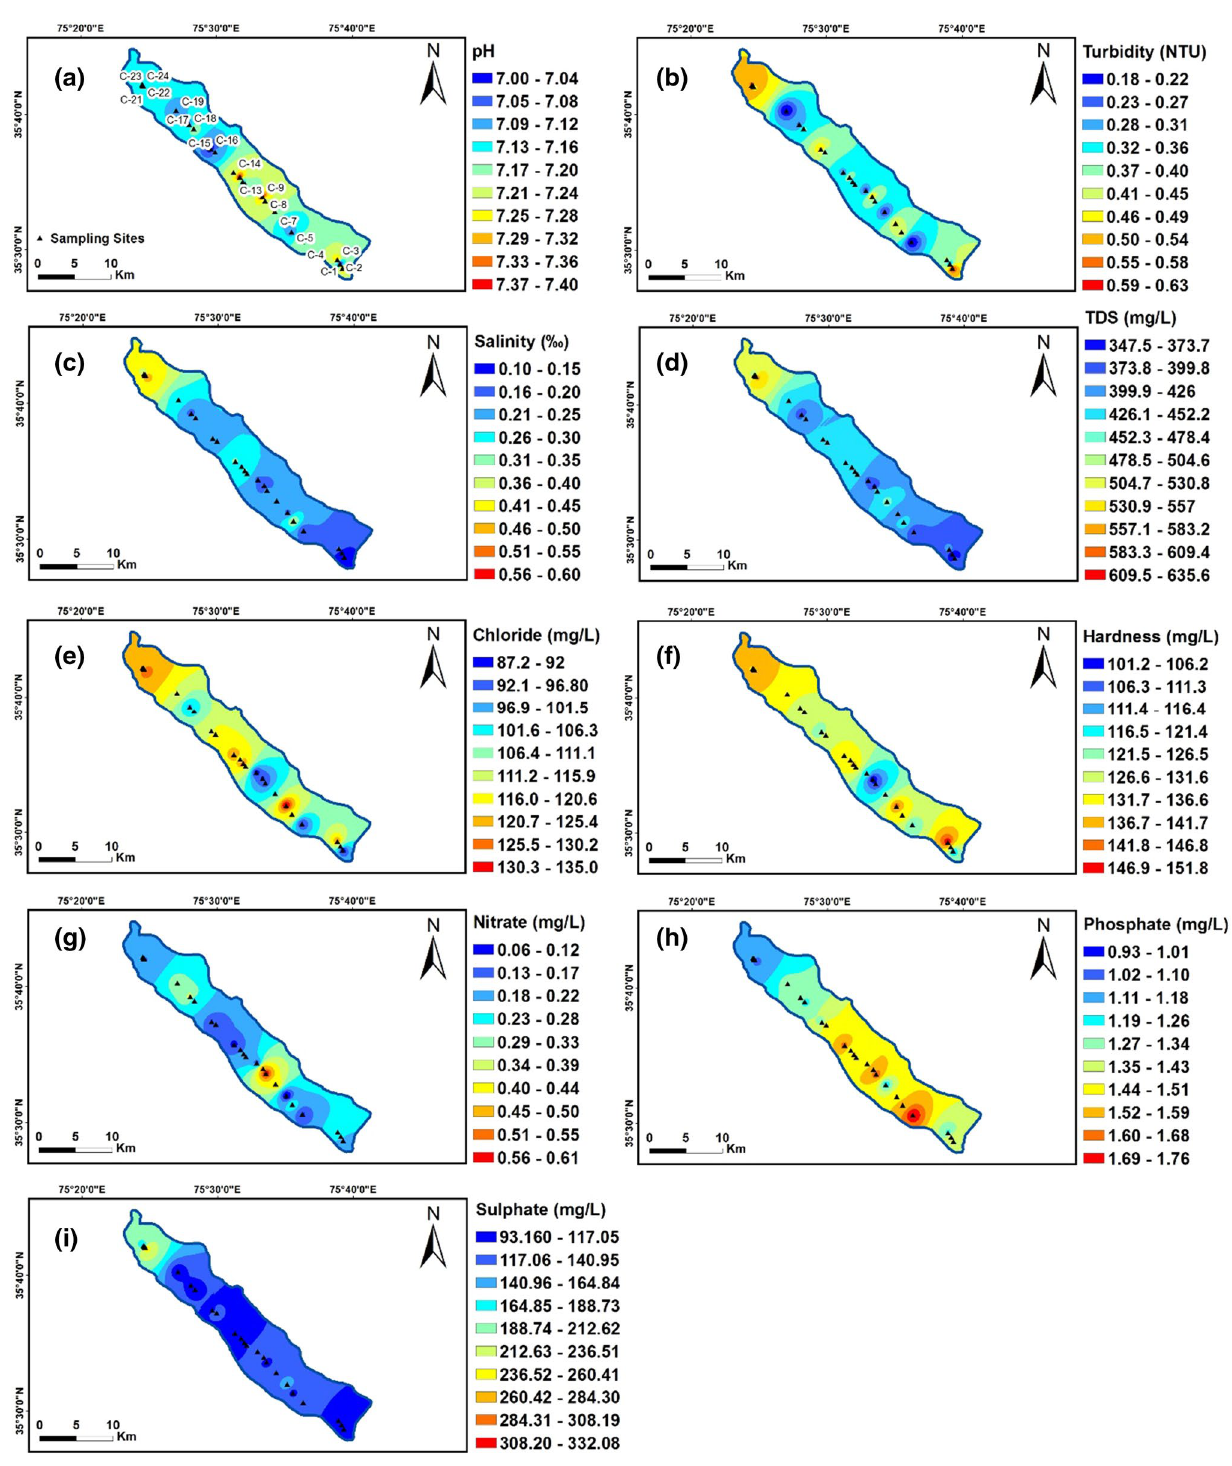
Fig. 8 IDW based spatial distribution of physico-chemical parameters a pH; b turbidity; c salinity; d total dissolved solids (TDS); e chlorides; f hardness; g nitrate (NO 3 − ); h phosphate (PO 4 − ); and (1) sulphate (SO 4 − ) in Chu Tran Valley water